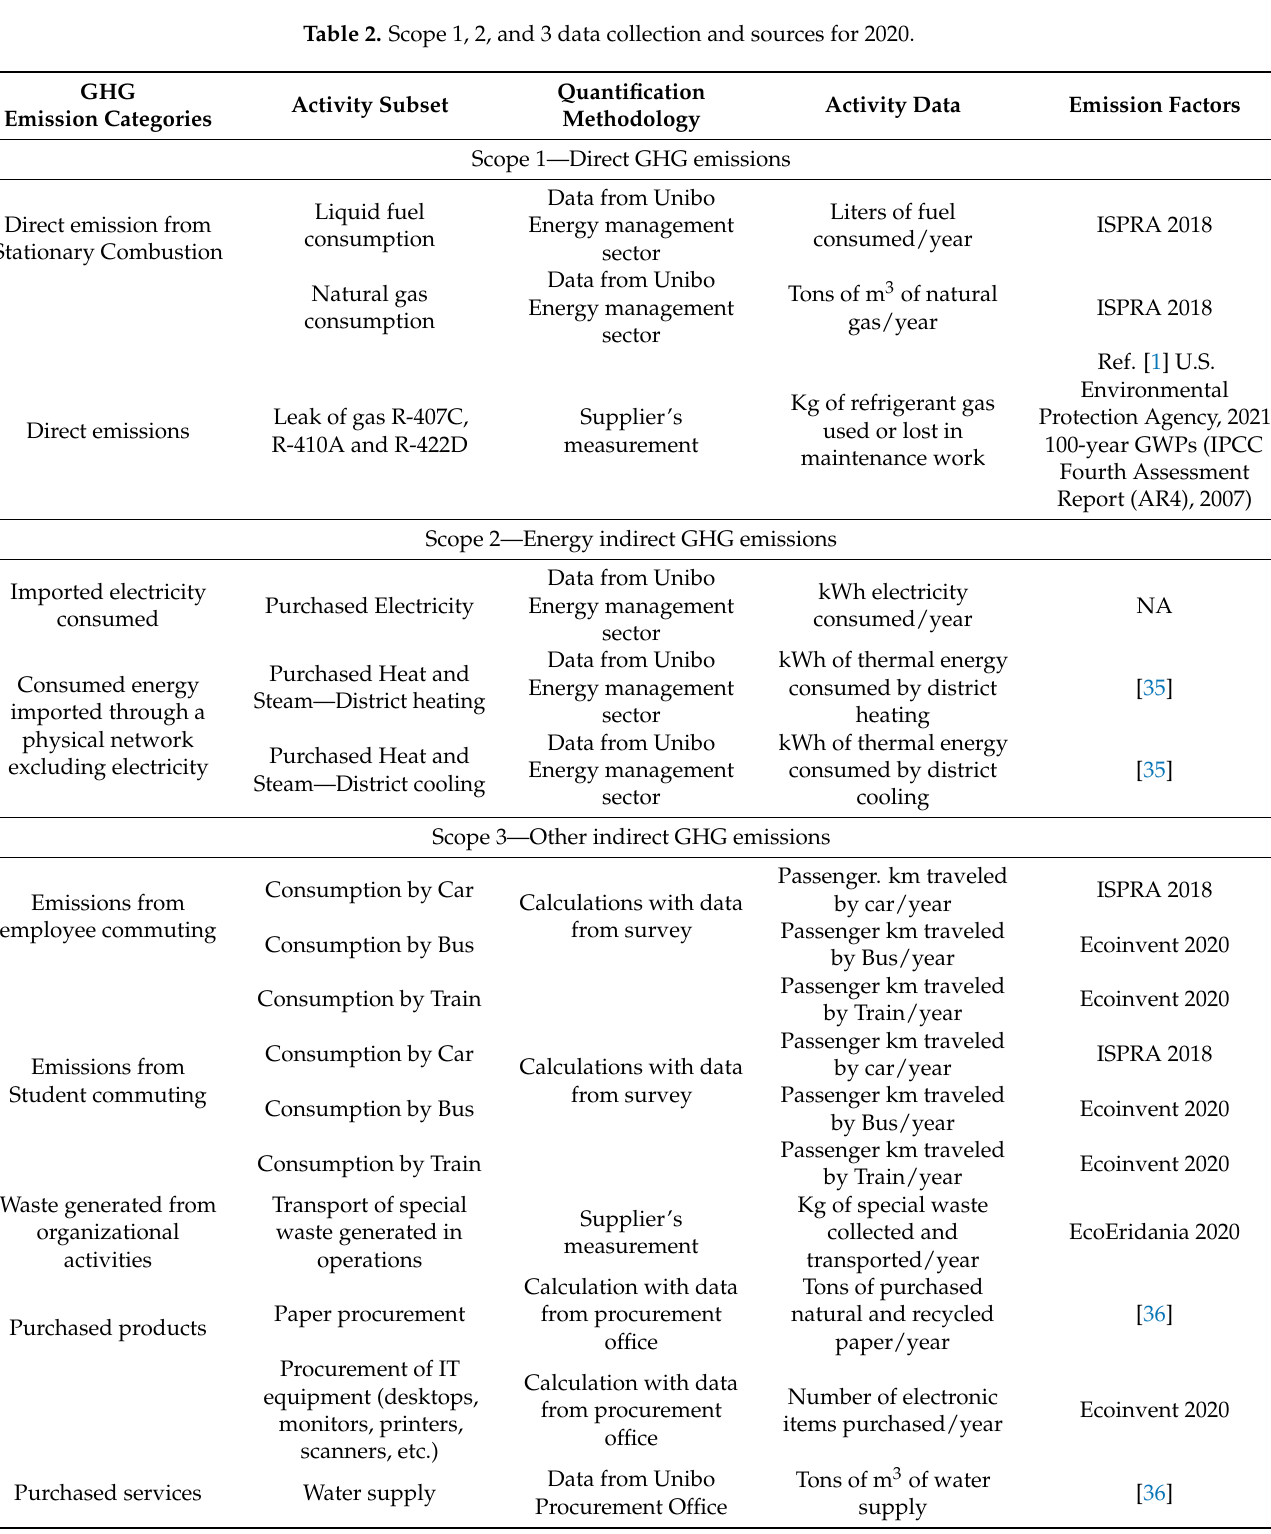
Table 2. Scope 1, 2, and 3 data collection and sources for